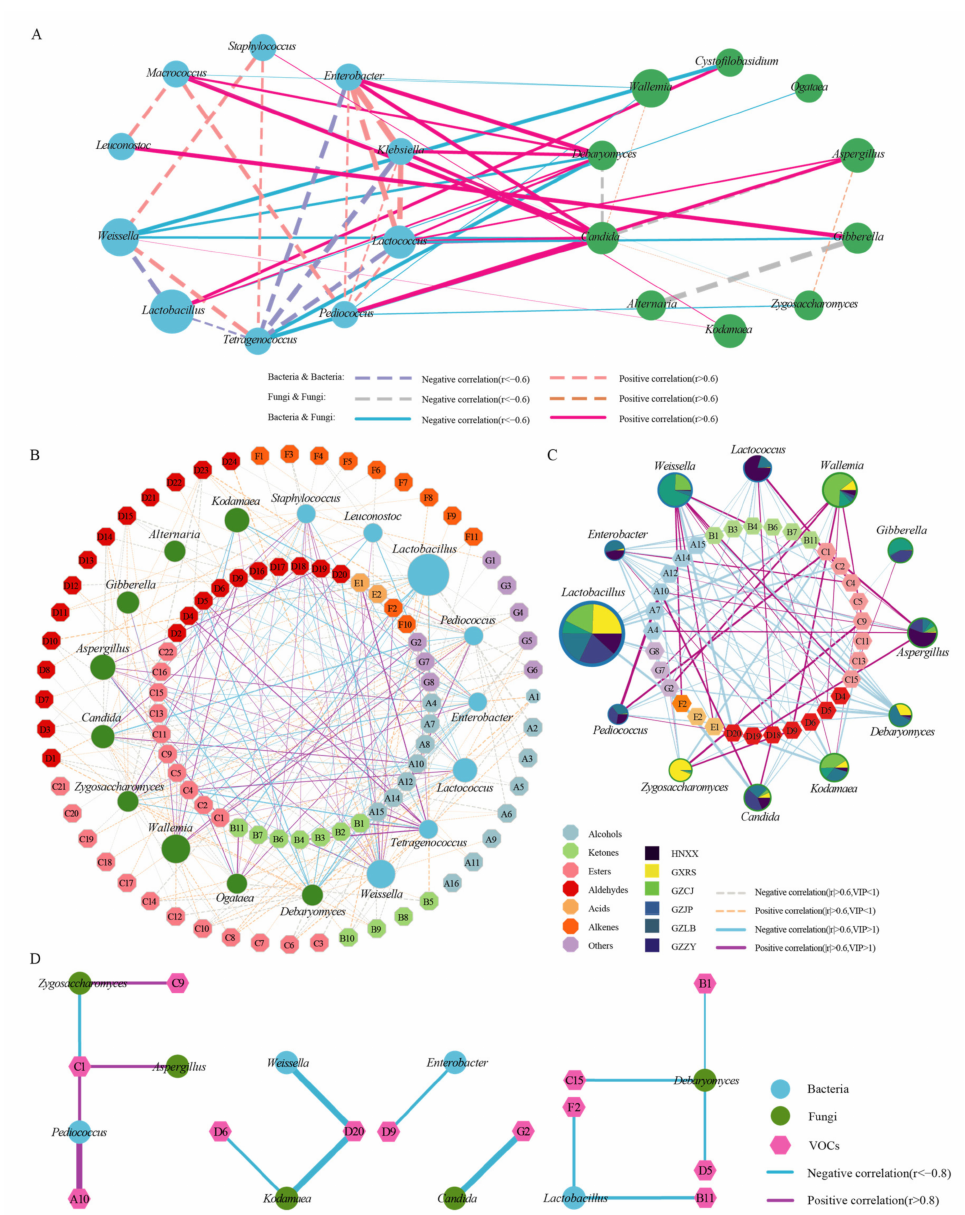
Figure 5. Correlation analysis. Statistical significance ( p < 0.05), Spearman correlation coefficient (|r| > 0.6, |r| > 0.8) represents correlation. ( A ) Association network diagram of bacteria and fungi. The orange and green circles refer to bacteria and fungi, respectively, and the purple and blue